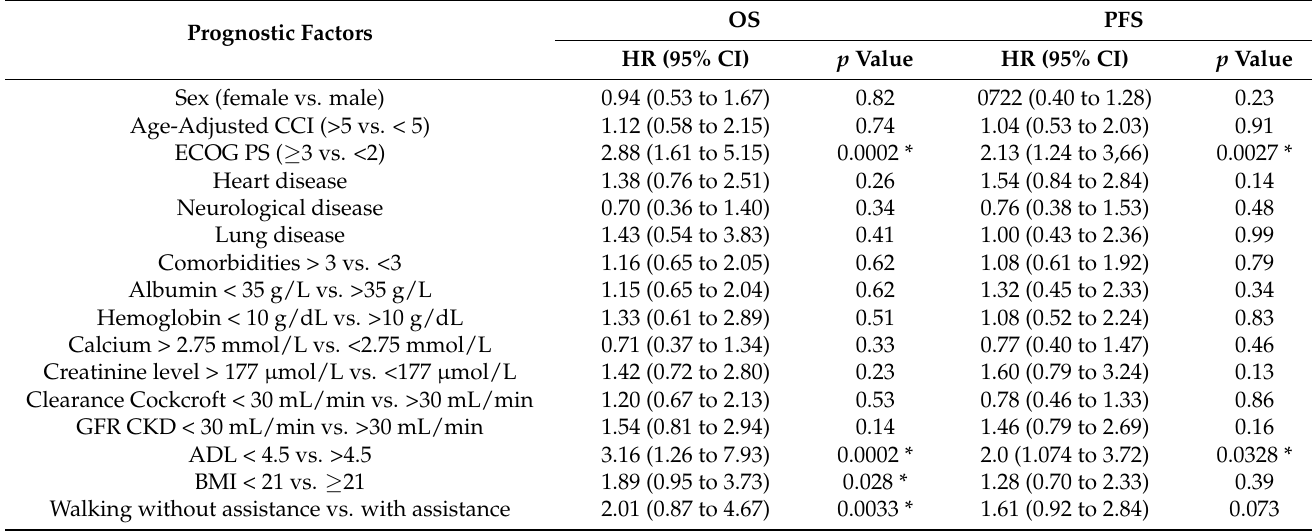
Table 3. Results of univariate statistical analysis. *: p < 0.05.